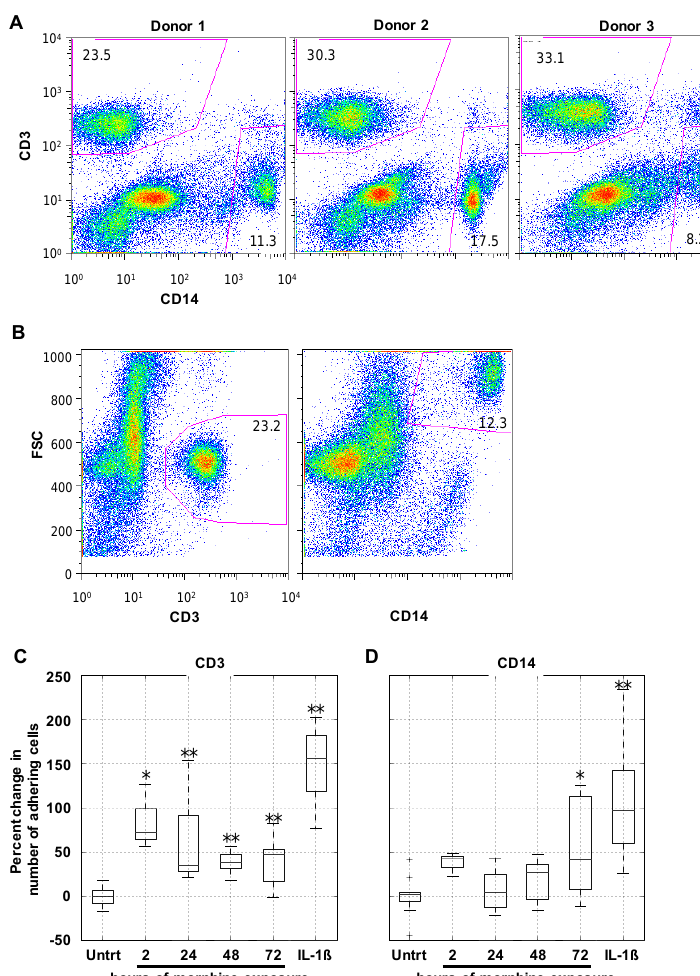
Figure 4. Prolonged morphine exposure increased peripheral blood mononuclear cell (PBMC) firm adhesion. hCMEC/D3 cells were grown to confluence as described earlier. At confluence, cells were exposed continuously to morphine (0.1 µM) for 2, 24, 48, or 72 h with re-administration at 24 h intervals. The final morphine administration preceded the adhesion assay by 2 h. As a positive control of enhanced adhesion, confluent hCMEC/D3 cells were exposed to IL-1β (20 ng/mL) for 24 h. Following treatment, a suspension of 1 million PBMCs in co-culture media was added to the hCMEC/D3 monolayer and the co-cultures were incubated at 37 °C in 5% CO 2 for 30 min to allow adhesion to occur. ( A ) At the start of each adhesion assay, the start population of PBMCs was stained for CD3 and CD14 and analyzed by flow cytometry. Each donor had comparable CD3 + and CD14 + viable cell populations, indicating that the representation of these cell types in the initial population was not the driving force behind any observed differences in selective cell adhesion; ( B ) population gates were established on forward scatter (FSC) and either CD3 or CD14, and the number of events within each of these gates was used in the analysis as the number of CD3 + and CD14 + PBMCs that adhered to the hCMEC/D3 monolayer. Representative scatter plots from Donor 1 are shown here; ( C ) morphine treatment for 2, 24, 48, and 72 h, as well as IL-1β treatment of the monolayer, increased the number of CD3 + cells firmly adhering to the hCMEC/D3 monolayer, as quantitated by CD3 staining and flow cytometric analysis; ( D ) morphine treatment of the monolayer significantly induce firm adhesion of CD14 + cells but only at the 72 h time point. Treatment of the monolayer with IL-1β is shown as a positive control for increased adhesion. All bars represent three independent experiments performed in triplicate, each with individual PBMC donor samples. * p ≤ 0.02; ** p ≤0.002 as determined by Student’s t -test.